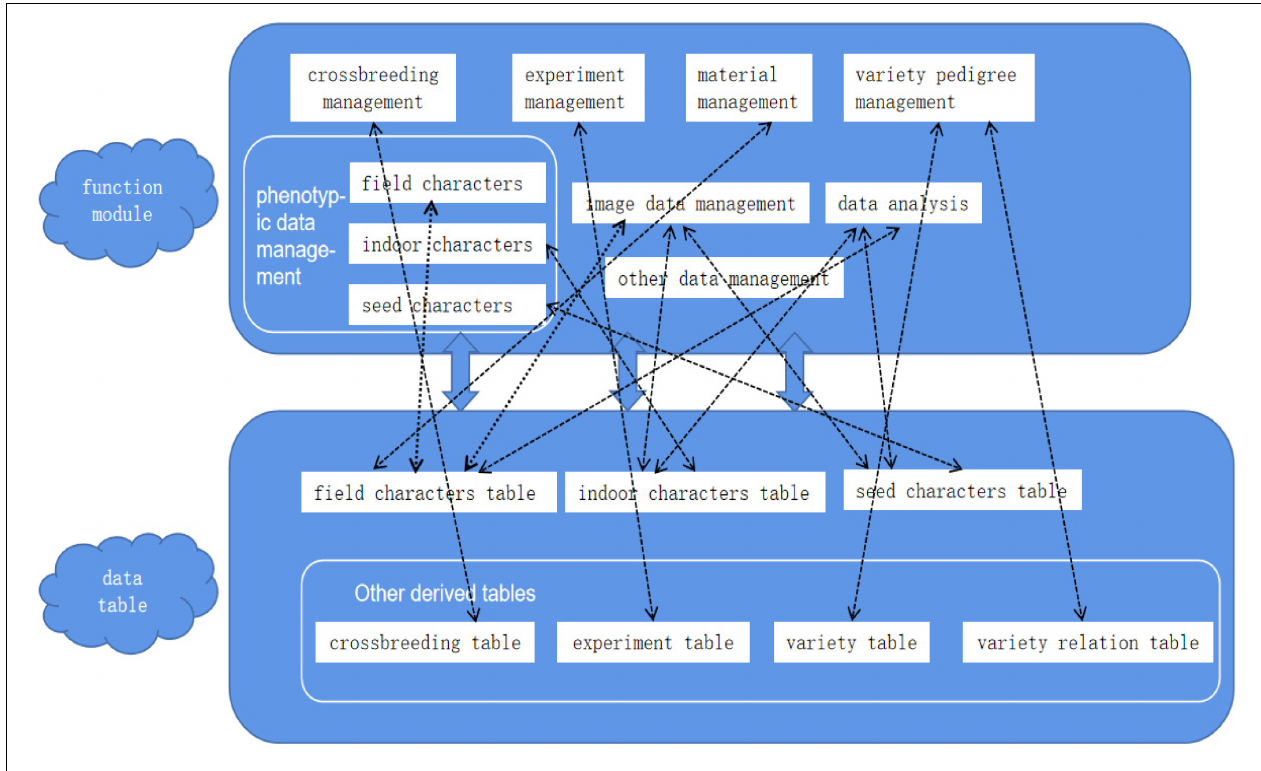
FIGURE 15 | Function module—data